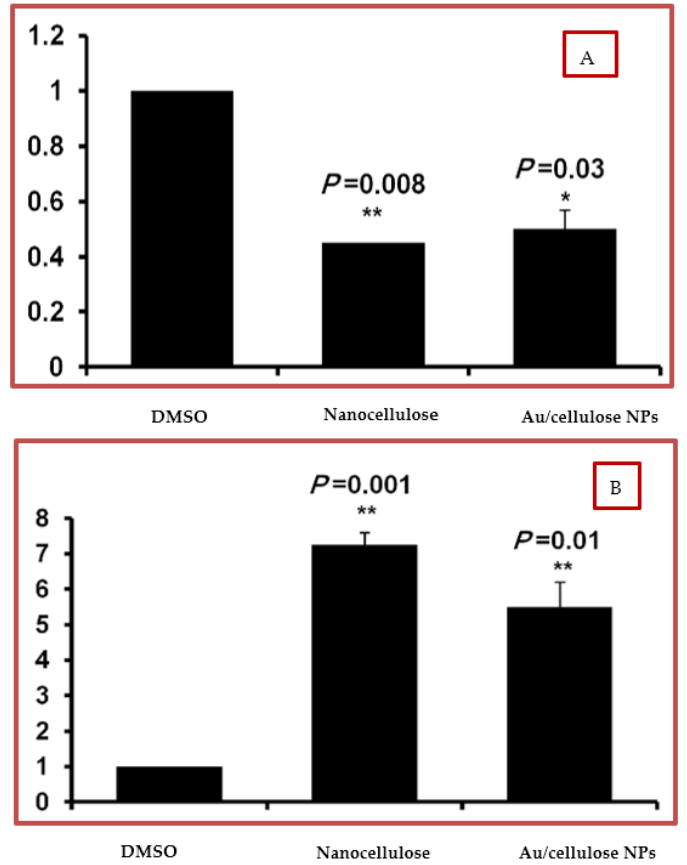
Figure 8. ( A ) Steady-state mRNA of the Raf-1 gene indicated by fold change in nanocellulose, and Au/cellulose nanocomposites compared with DMSO-treated cells. ( B ) Steady-state mRNA of the p53 gene indicated by fold change in nanocellulose and Au/cellulose nanocomposites in comparison with DMSO-treated cells. Levels of GAPDH-mRNA were used as an internal control. *P < 0.05 was considered statistically significant and **P < 0.01 as highly significant. The percentage of positive events was linked to the relative fluorescent intensity of the Alexa Fluor signal to measure the amount of pho-P53 stabilization in cells treated with nanocellulose and Au/nanocellulose composites against DMSO. Regarding nanocellulose